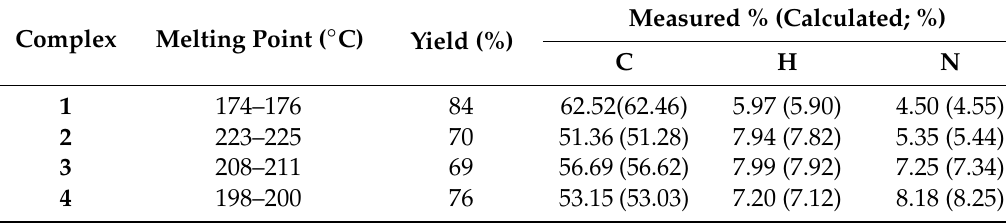
Table 1. Melting point, yield, and elemental analyses for complexes 1–4 .